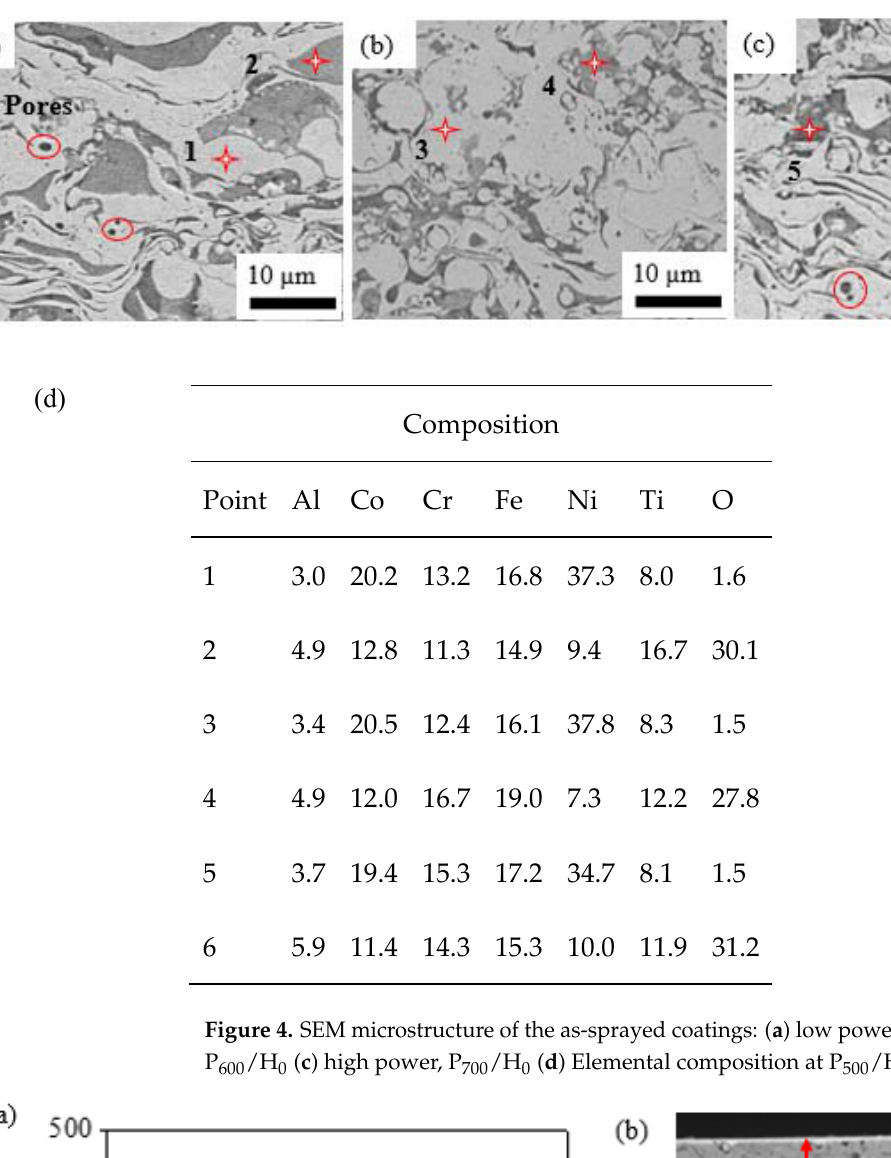
Figure 3. Macroscopic image of the Al 0.5 CoCrFeNi 2 Ti 0.5 ‐ sprayed coatings.